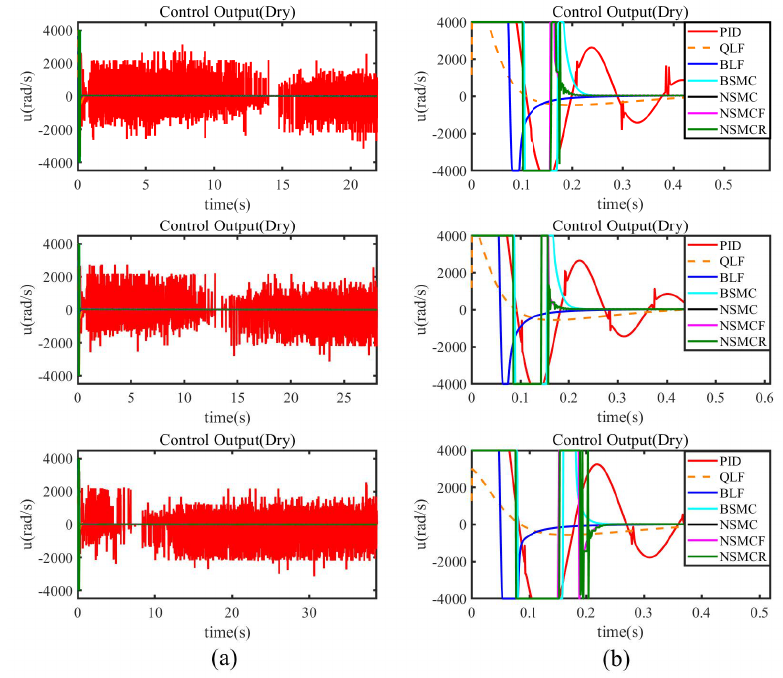
Figure 9. Simulation results of control chattering with different algorithms in 3 runway conditions.